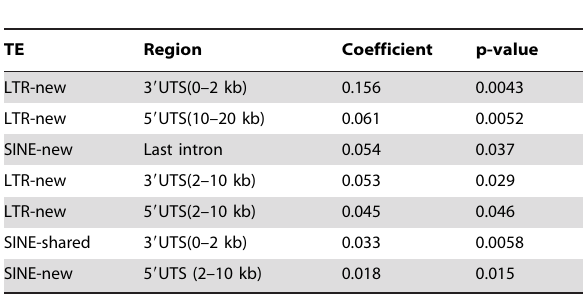
Table 3. The regression coefficients from a stepwise multiple regression of ED against the numbers of new and shared TEs in each region.